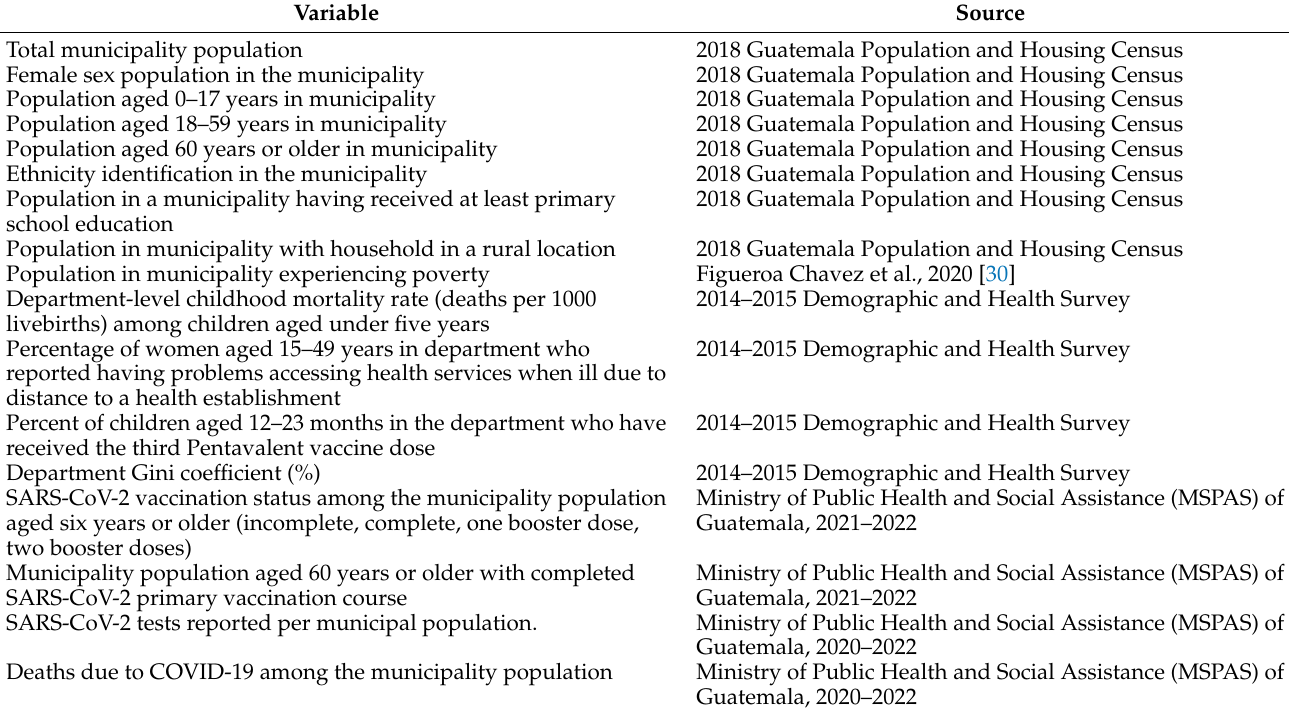
Table 1. Data elements used in the